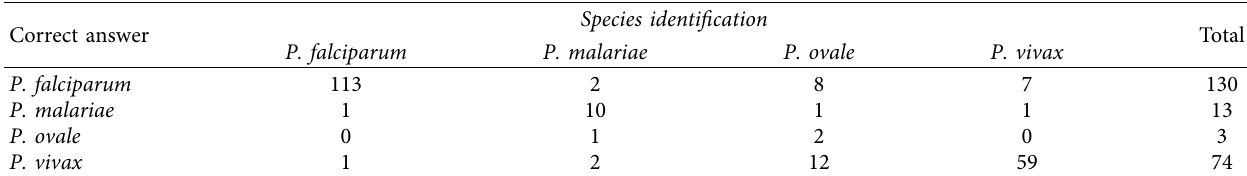
Table 2: Species identification of the Plasmodium -positive slides correctly in the qualitative microscopy by representatives from provincial CDCs/IPDs.